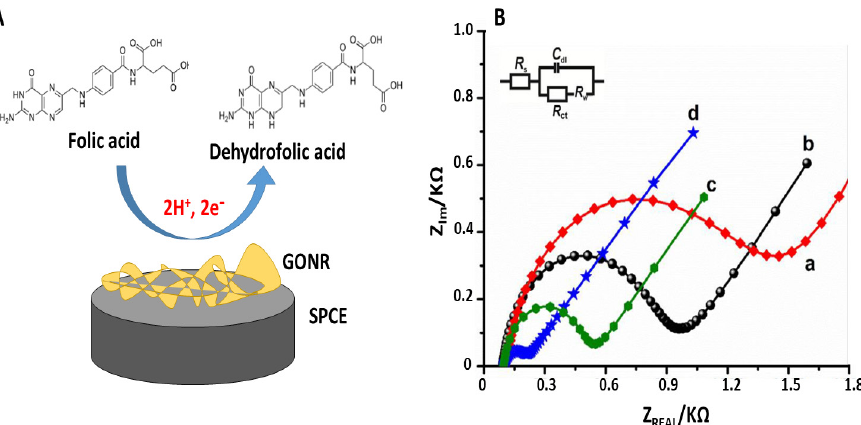
Figure 7. ( A ): Scheme of the electrochemical oxidation of FA on GONR/SPE. ( B ): EIS curves of un- modified SPE (a) MOS 2 -SPE (b), GNS-MoS 2 /SPE (c), MoS 2 -AuNPs/SPE, (d) in 0.1 M KCl containing 5 mM Fe(CN) 6 3 − /4 − . Frequency: 0.1 Hz to 100 kHz